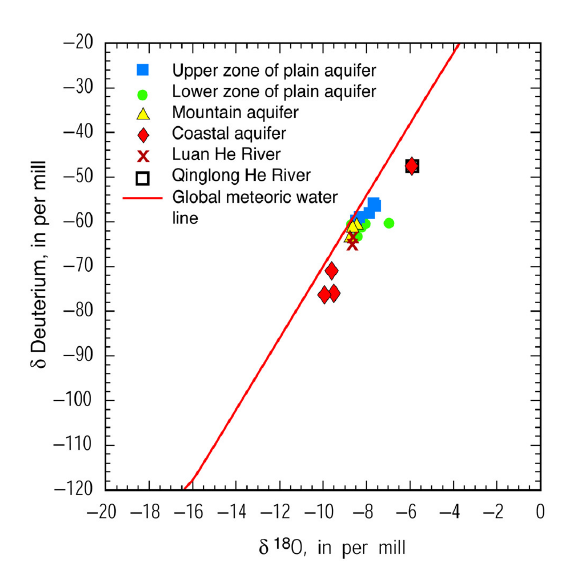
FIGURE 4. Boxplots of stable isotopes δ deuterium ( 2 H) vs. 18 O of groundwater in the Tangshan study areas and the Qinglong and Luan He Rivers.